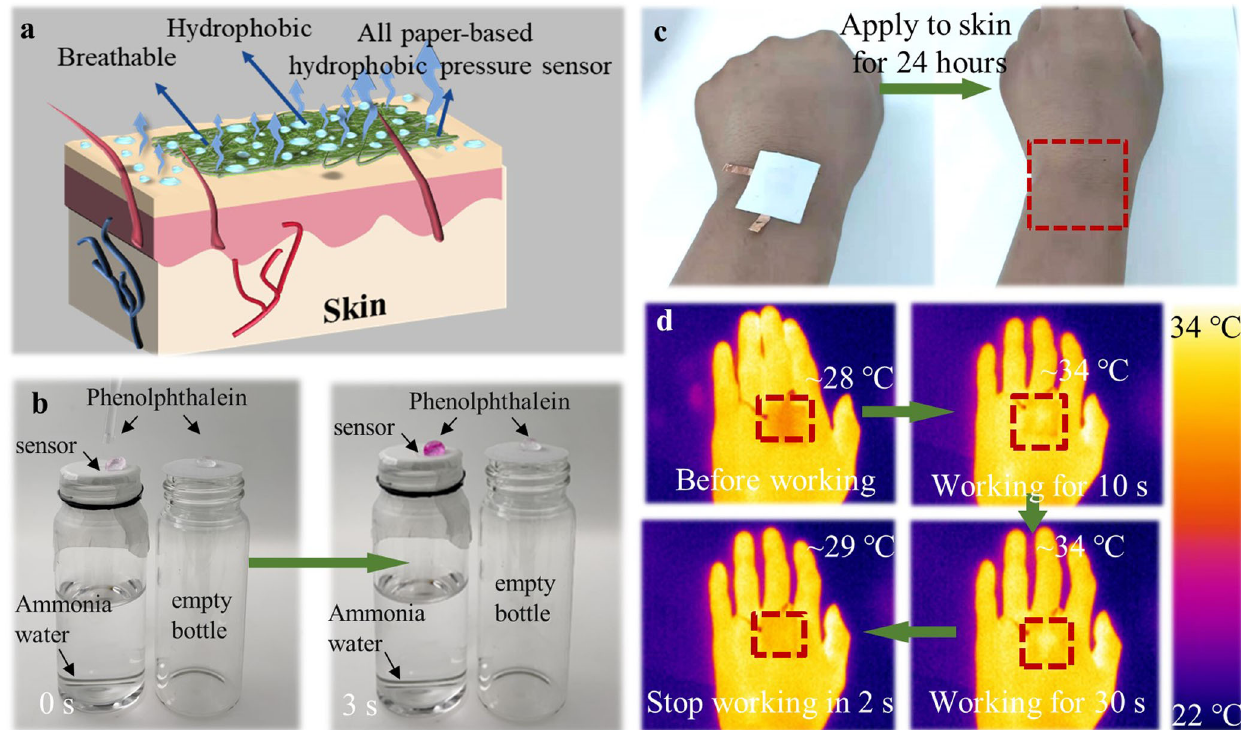
Fig. 3 Hydrophobic and air permeable properties of the fully paper-based fl exible piezoresistive sensor. a Schematic diagram of a sensor attached to human skin with air permeable and hydrophobic effects. b Air permeability test of the fl exible piezoresistive sensor. c A photograph of the piezoresistive sensor worn on the skin (left) and a photograph of the skin after wearing it for 24 hours (right). d Infrared images of the sensor before working (top left), working for 10 seconds (top right), working for 30 seconds (bottom right), and stopping working in 2 seconds (bottom